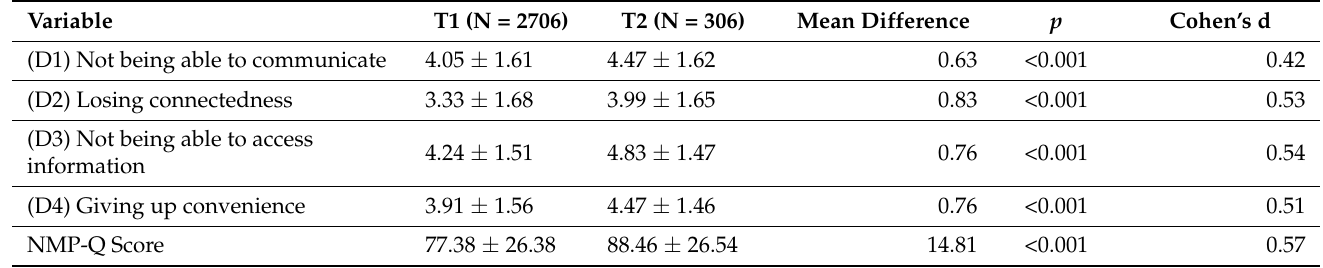
Table 2. Nomophobia scores at baseline and during the social media outage.